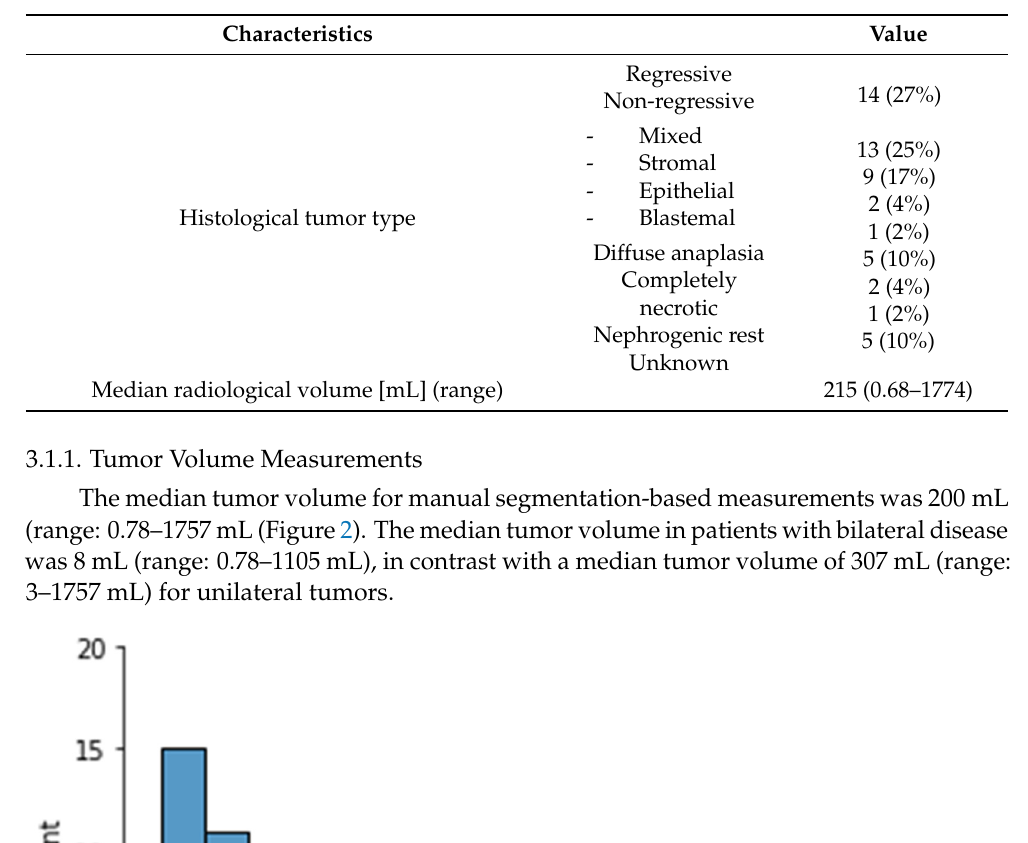
Figure 3. Radiological vs. manual-based tumor volumes. The volume di ff erence plo tt ed on the y- axis was calculated by extracting the radiological tumor volumes from the manually measured reference volume. The red line corresponds to no di ff erence with the manually determined reference volume. Because radiological tumor volume was subtracted from the reference volume, a point above the red line presents an underestimation of tumor volume by the radiologist while points below the line represent an overestimation of tumor volume. In grey, the median and 2.5–97.5 percentile are plo tt ed. When the tumors were divided into three groups based on their manual volume (0– 300, 300–500 mL, and >500 mL) there was a signi fi cant increase in the absolute di ff erence between the radiological and manual segmentation volume. However, the di ff erence in the percentage of the volume was the same for the three groups (please refer to Table 4). Table 4. Di ff erences between radiological and manual segmentation volume in absolute numbers and percentages. Volume Tumor